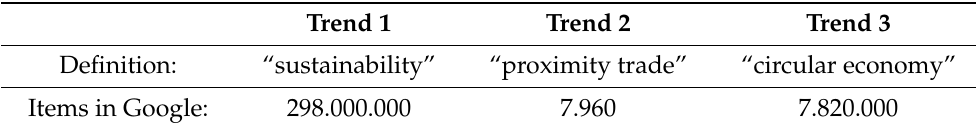
Table 2. Trends considered in the